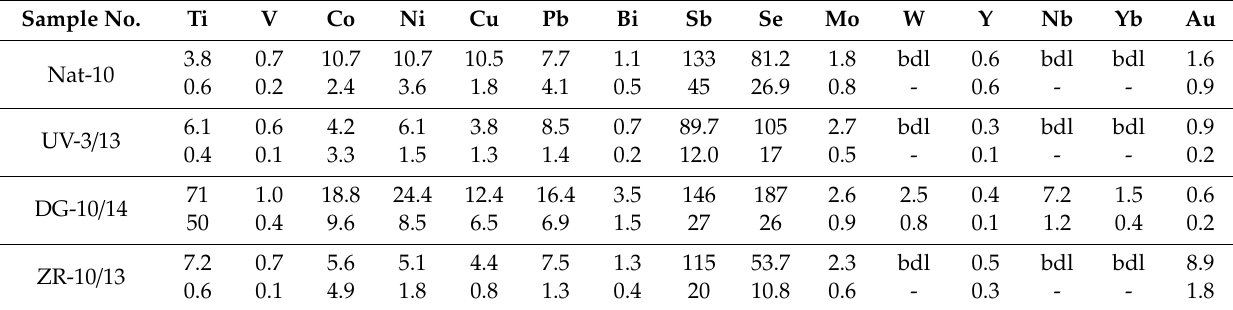
Table 6. Refined LA-ICP-MS data (in ppm) for arsenopyrite coexisting with pyrite at the orogenic gold deposits located in north-eastern Russia (Magadan Region). Sample No.